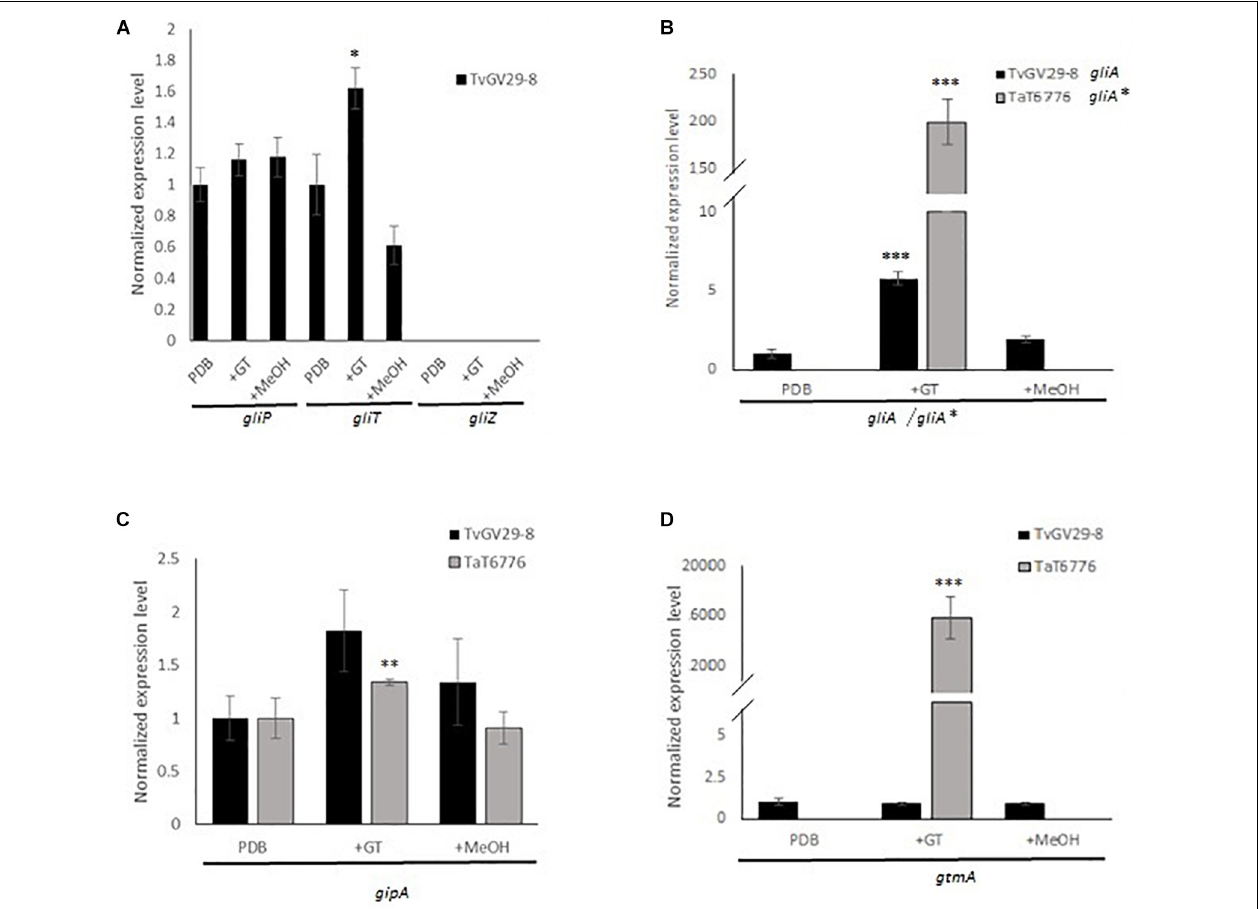
FIGURE 2 | Compared gene expression analyses in TvGv29-8 and TaT6776 grown in potato dextrose broth (PDB), in PDB amended with 5 µ g/ml of gliotoxin (+GT), or amended with methanol (+MeOH). (A) gliP , gliT , and gliZ in TvGv29-8, no transcriptions were detected in TaT6776; (B) gliA/gliA* [major facilitator superfamily (MFS)/ATP-binding cassette (ABC) transporter]; (C) gipA ; (D) gtmA . Each real-time PCR (RT-PCR) reaction was performed in three biological and technical replicates. For statistical analysis, ANOVA test was applied with significance defined as a p value (* p ≤ 0.02; ** p ≤ 0.001, *** p ≤